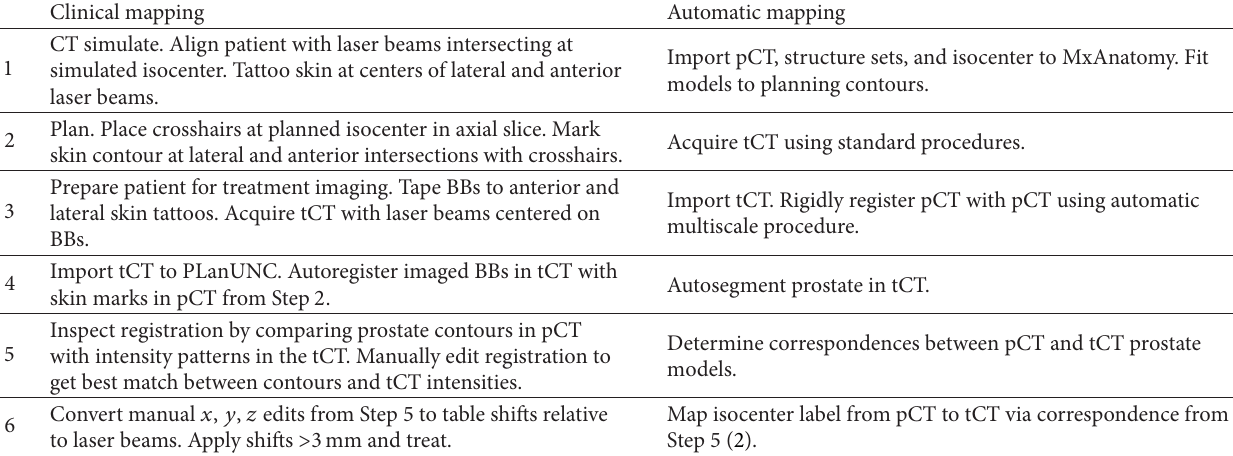
Figure 1: (a) Axial slice from the pCT showing planning prostate (white) and isocenter (black). (b) Corresponding slice from the tCT showing the prostate (black) segmented by automatic nonrigid model deformation. The rigidly mapped isocenter comes from translating the planning prostate (dim white) to the tCT. The nonrigidly mapped isocenter comes from applying the deformation matrix resulting from autosegmentation to the planned isocenter. Table 1: Isocenter Mapping